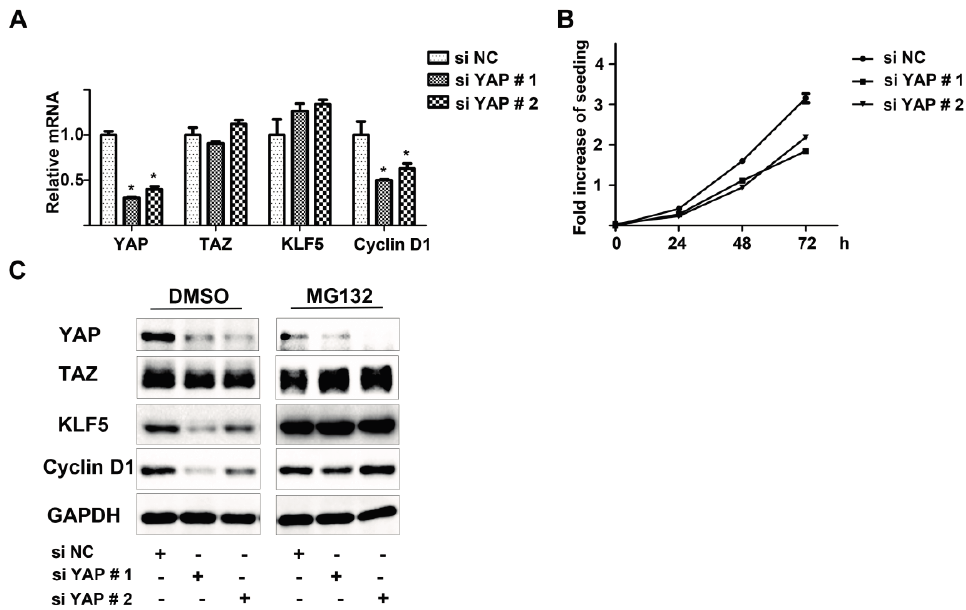
Figure 5. Knockdown of YAP attenuated KLF5 protein, but not mRNA